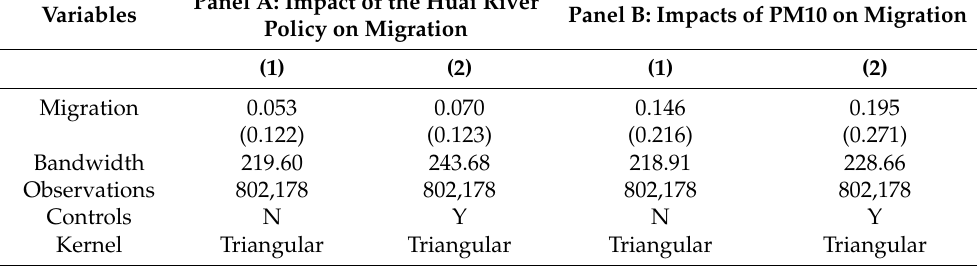
Table A4. RD estimates of the impacts on migration.